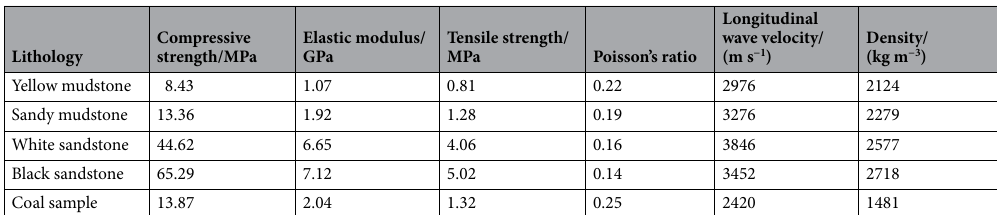
Table 1. Mechanical parameters of coal and rock samples.